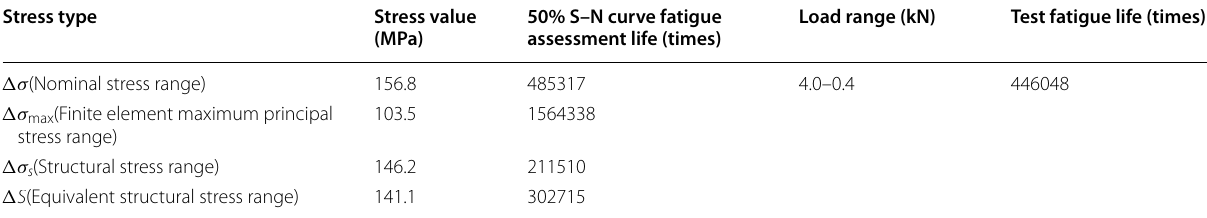
Table 7 Comparison of fatigue test results and evaluation life of test sample type 1 Stress type